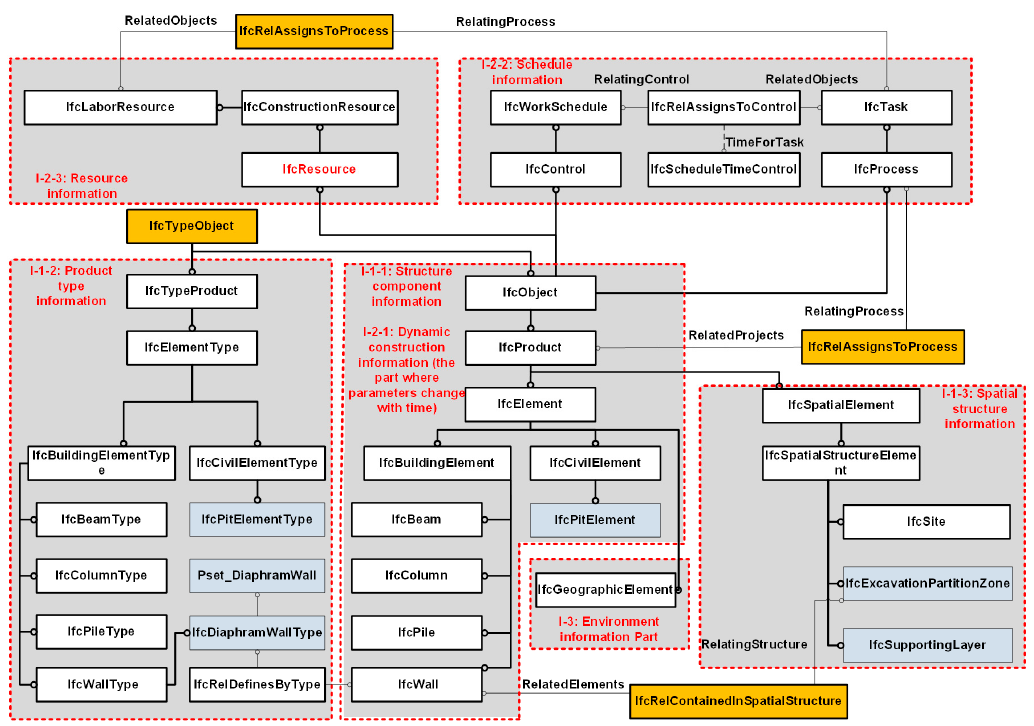
Figure 11. Framework of the IFC data model for safety risk identification of deep excavation